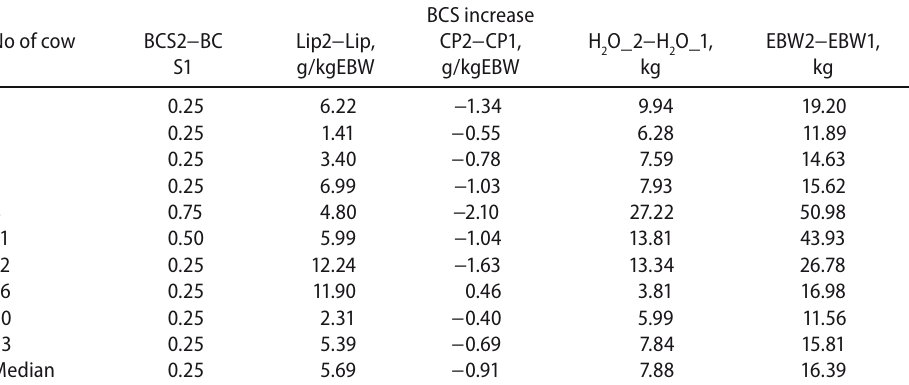
Values of differences of parameters and their medians for cows at III phase of lactation whose BCS